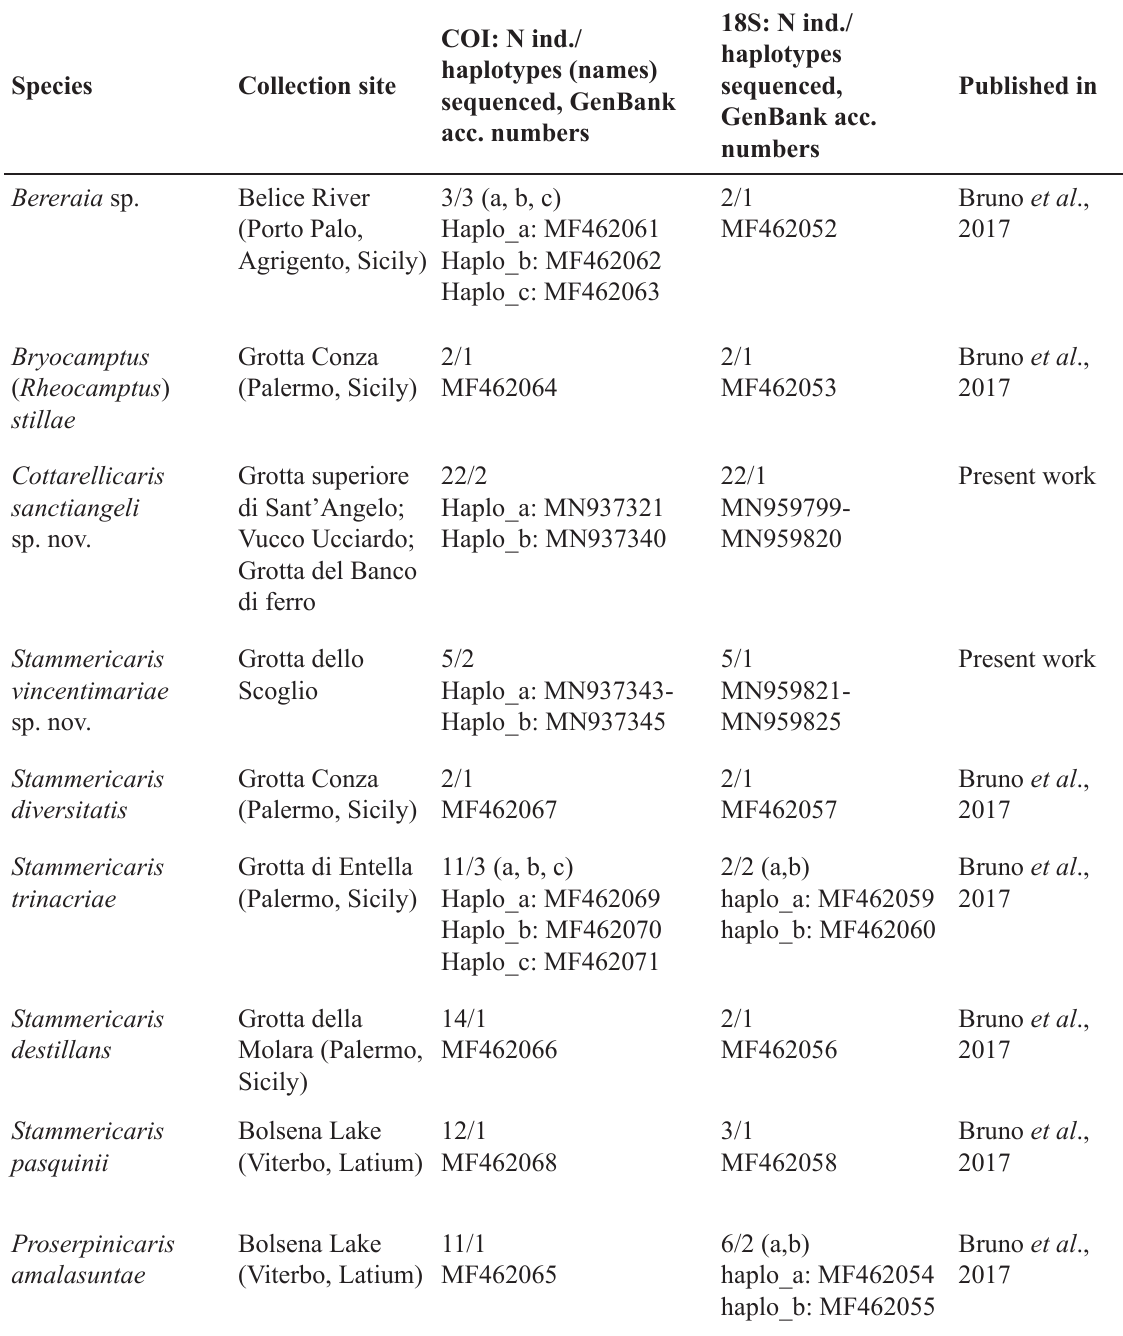
Table 2. List of species used for phylogenetic analysis, collection site, number of specimens for which DNA was successfully extracted and amplified for the two investigated fragments (COI and 18S), number of haplotypes recorded for each species/fragment, and GenBank accession